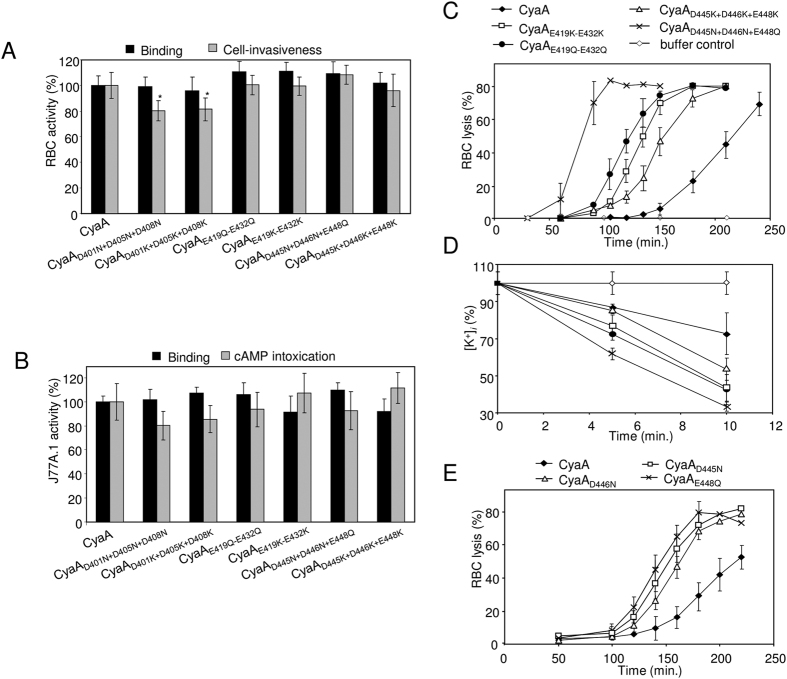
Substitutions of glutamate and aspartate residues in blocks II and III of the ‘AC to Hly-linking segment’ enhance pore-forming capacity of CyaA without altering AC translocation.(A) Sheep erythrocytes (5 × 108/ml) were incubated at 37 °C with 1 μg/ml of the purified CyaA proteins for 30 min. Aliquots were taken for determination of the cell-associated AC activity and of the AC activity internalized into erythrocytes and protected against digestion by externally added trypsin, respectively. The activities are expressed as percentages of intact CyaA activity (100%) and represent average values ± standard deviations from at least three independent determinations performed in duplicate with two different toxin preparations (n ≥ 6). Asterisks indicates values significantly different from intact CyaA (*p < 0.05). (B) Binding of the CyaA proteins to J774A.1 cells (106) was determined as the amount of total cell-associated AC enzyme activity upon incubation of cells with 1 μg/ml of the protein for 30 min at 4 °C. cAMP intoxication was assessed by determining the intracellular concentration of cAMP generated in cells upon incubation of J774A.1 cells (2 × 105) with four different toxin concentrations from within the linear range of the dose-response curve (100, 50, 25, 10 ng/ml). The percentage of cAMP accumulation in cells at each toxin concentration was calculated, taking cAMP values for intact CyaA as 100%. (C,E) Sheep erythrocytes (5 × 108/ml) in TNC buffer were incubated at 37 °C in the presence of intact CyaA or of its mutant variants (10 μg/ml) or the urea buffer control. Hemolytic activity was measured as the amount of released hemoglobin by photometric determination (A541 nm). Error bars represent standard deviations from four independent measurements performed with two different toxin preparations. (D) J774A.1 macrophages (106/ml) in modified HBSS buffer without KCl were incubated with 500 ng/ml of intact CyaA or of its mutant variants, or the urea buffer only. The reaction was stopped at 5 or 10 min of incubation, the cells were pelleted by centrifugation, washed in modified HBSS and lysed by deionized water. Lysates were diluted with deionized water and analyzed by ICP–MS. Error bars represent standard deviations of four samples measured in two independent experiments.